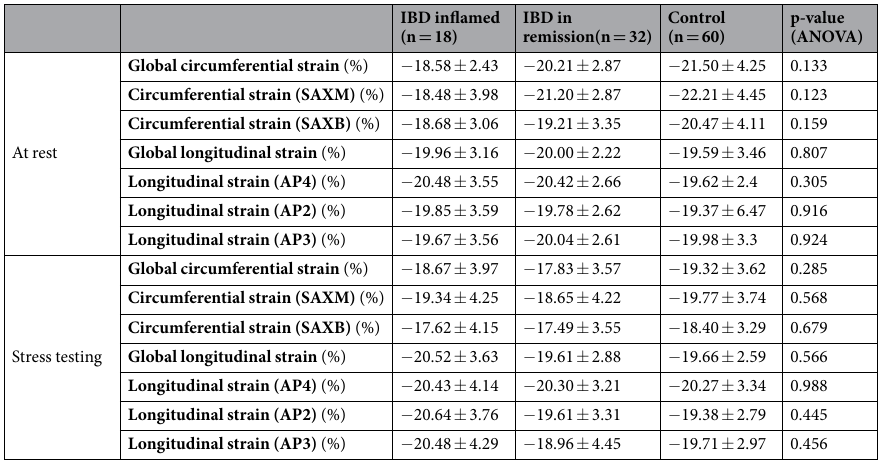
Table 4. Speckle tracking derived peak systolic LV strain at rest and during stress testing.